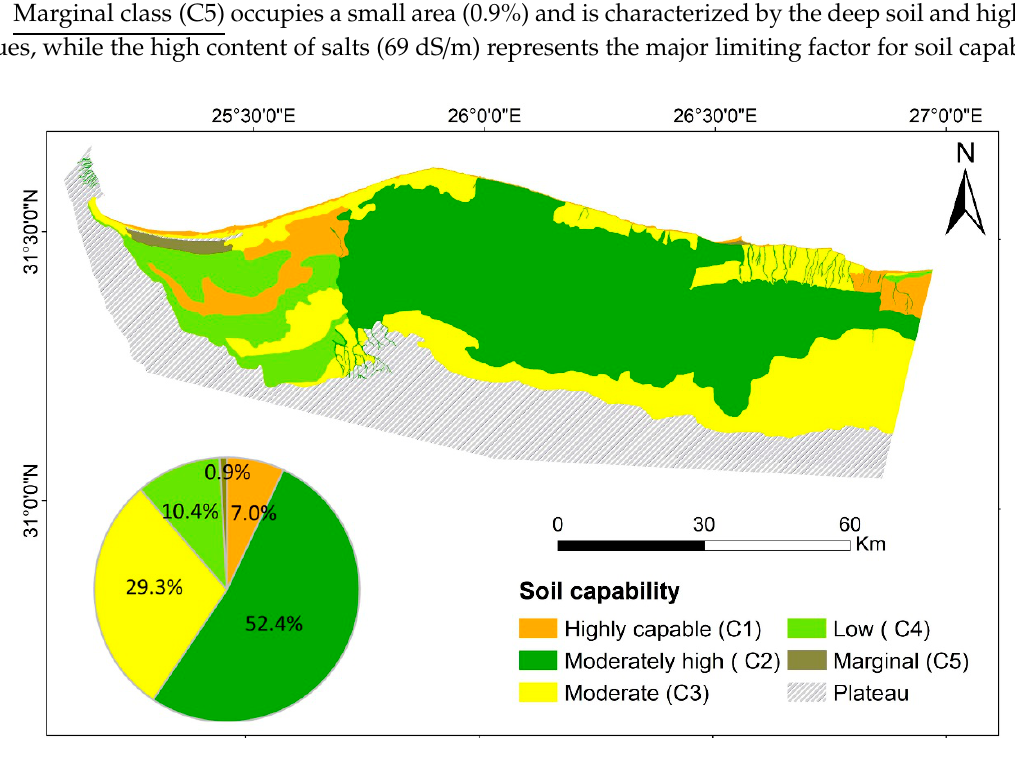
Figure 7. Land capability units and the pie chart represent the percentage area.